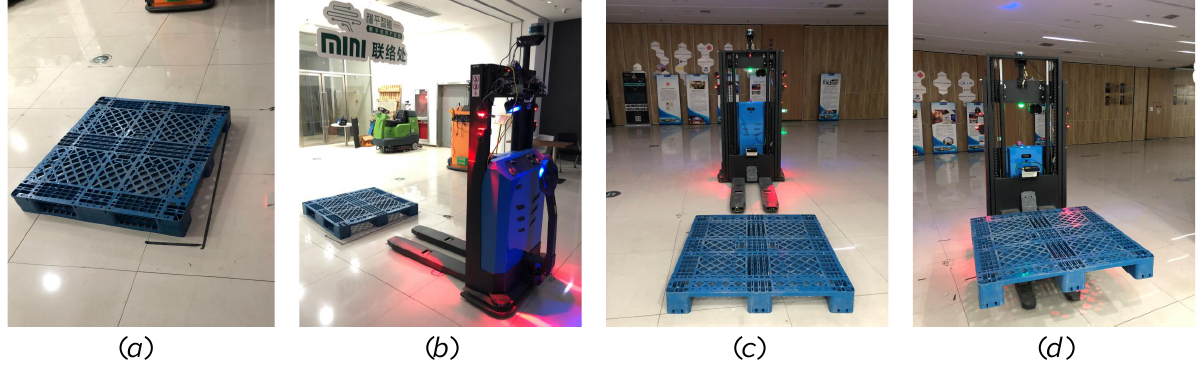
Figure 15. Empty space near the pallet placement position. ( a ) Pallet. ( b ) Photo spot. ( c ) Correction point. ( d ) Pallet fork.